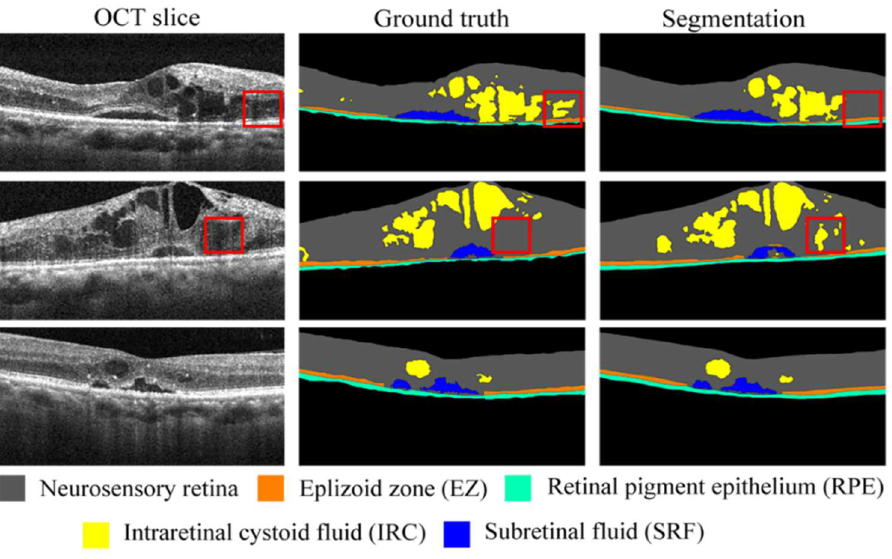
Figure 4. Randomly selected OCT images of three patients with DME (left column), their corresponding ground truth images (middle column), and segmented images (right column). Red boxes in first and second rows indicate differences between ground truth and segmentation.